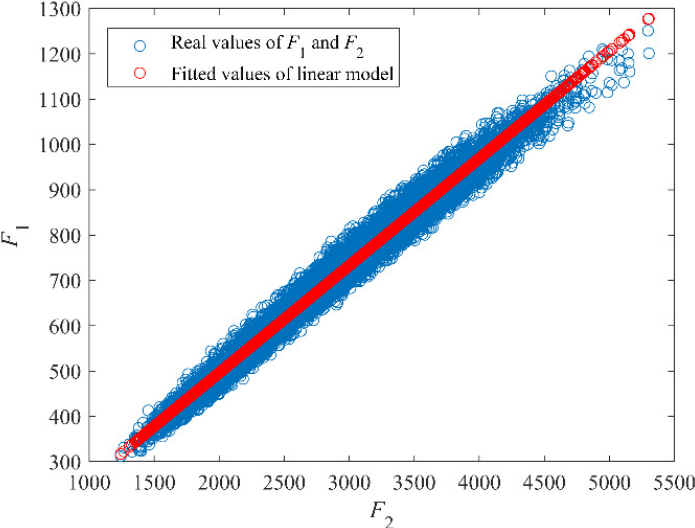
Figure 4. The relationship of Euclidean distance ( F 1 ) and Manhattan distance ( F 2 ) for the formulation of SR-DRLP.